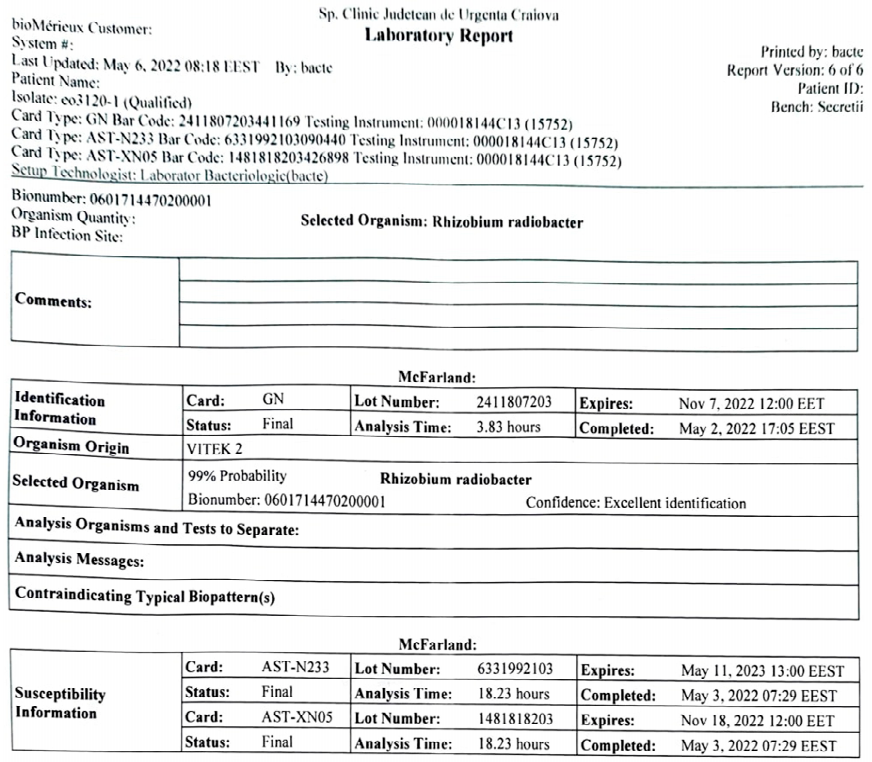
Figure 4. Automated identification results of Rhizobium radiobacter on the VITEK2 compact system .